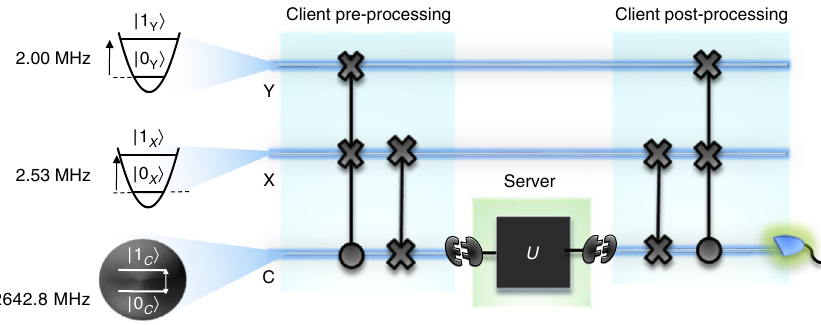
Fig. 2 Modular DQC1 on a trapped ion. The modular DQC1 algorithm redesigned to function on a 171 Yb þ ion. Here, the control qubit C is encoded within two hyper fi ne levels of the S total internal angular momentum and m and Y are encoded within the ground and fi rst excited states of two radial motional modes in 171 Yb þ , denoted as j 0 frequencies of modes X and Y are given by 2.53 and 2.00 MHz. After suitable preprocessing, information encoded within the control qubit can be forwarded to an external server via a suitable interface where the action of U